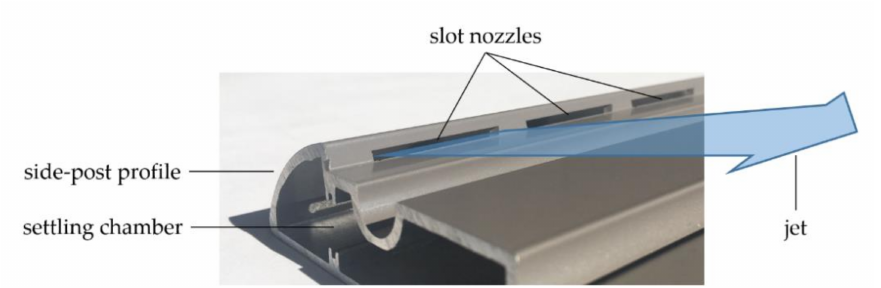
Figure 5. Slot-shaped jet exit openings on the side post, baseline fume hood. Photography of the cut-open hollow aluminum profile. Jet shown